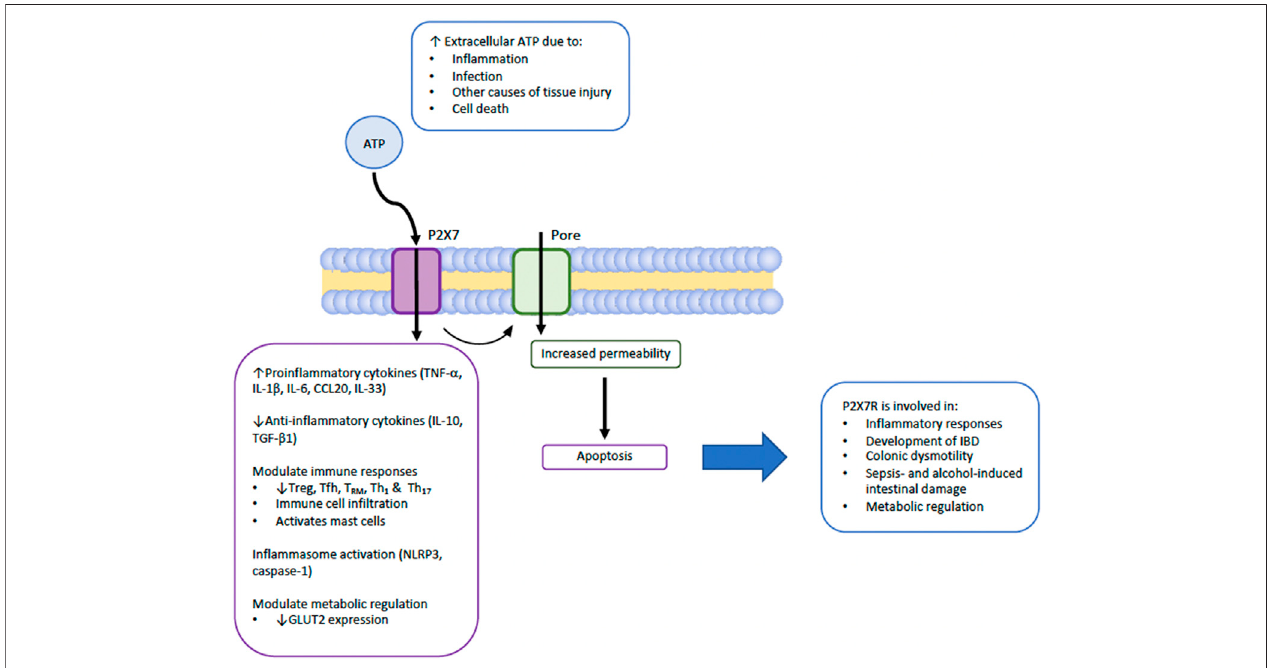
FIGURE 2 | Summary of the primary actions of P2X7R in the GI